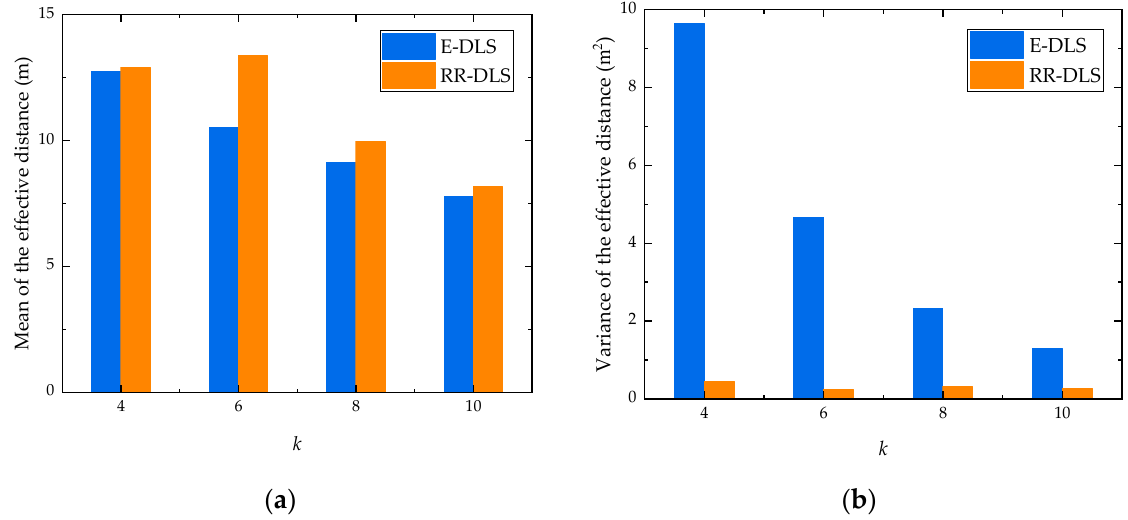
Figure 9. Effective distance of two different location selection algorithms. ( a ) mean; ( b ) variance.